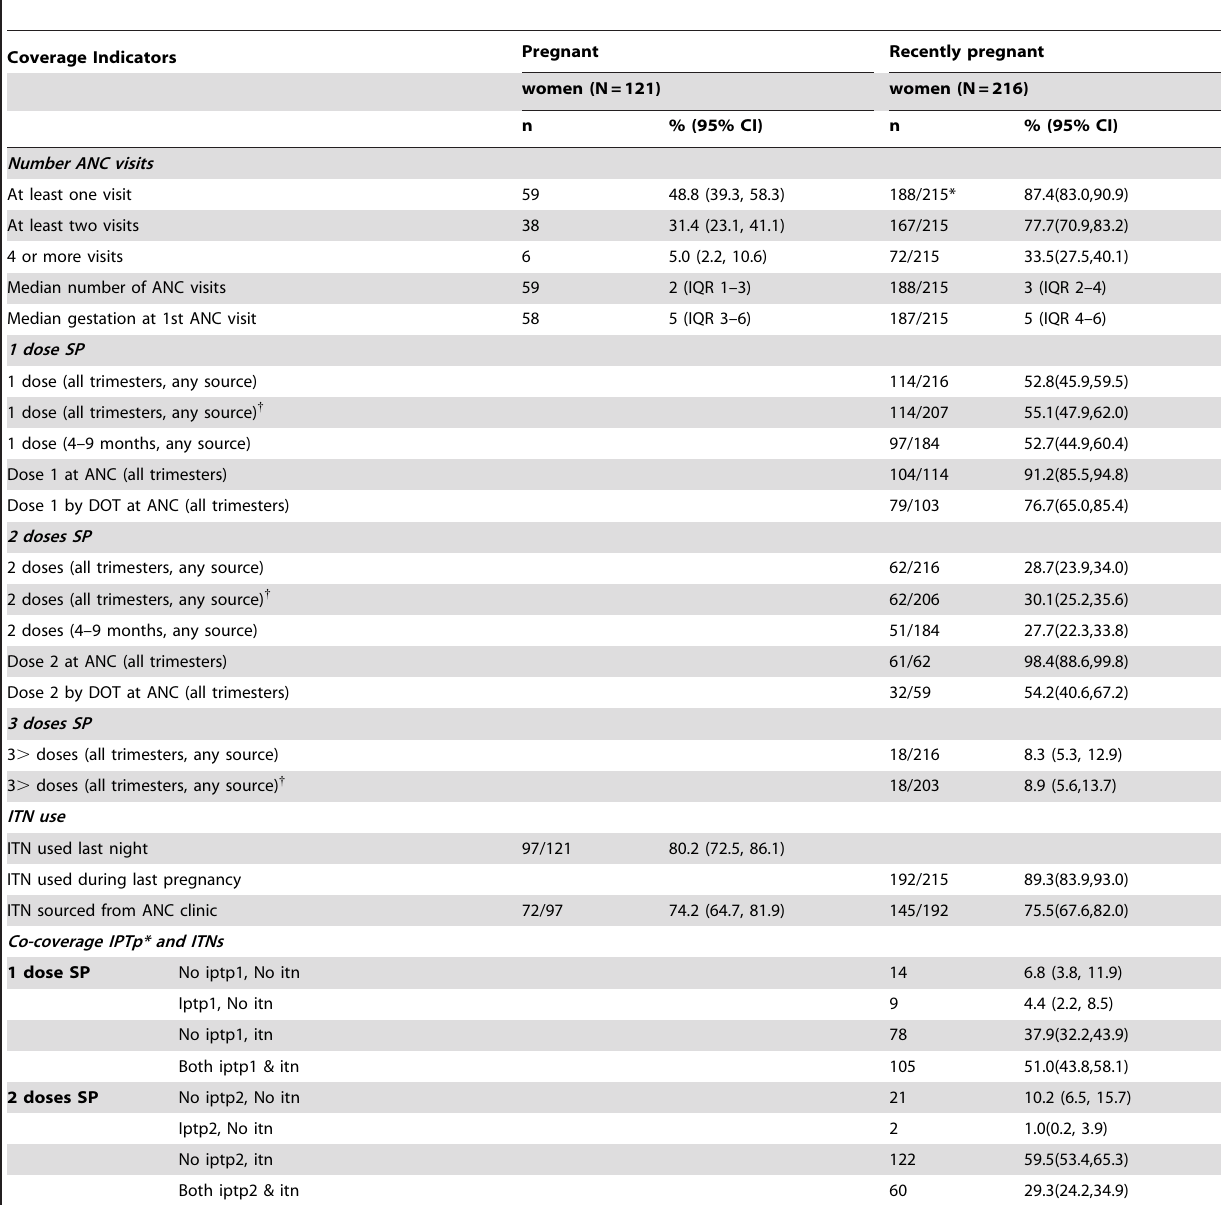
Table 2. Key coverage indicators for ANC attendance and malaria in pregnancy interventions among pregnant women and recently pregnant